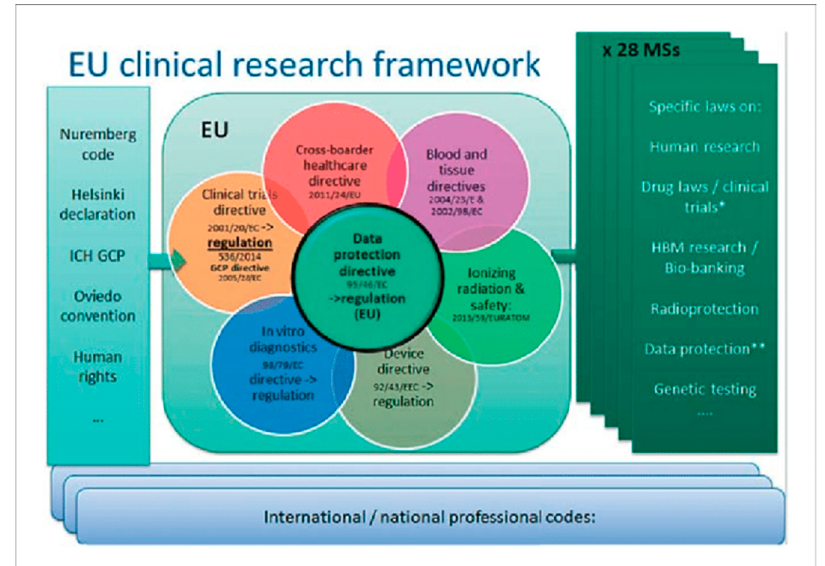
Figure 9. European Union clinical research framework.